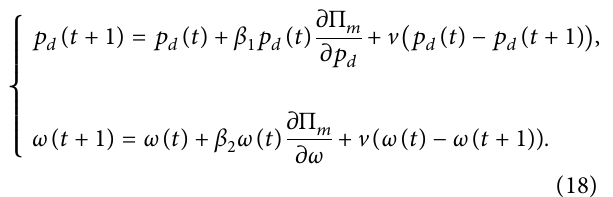
interval. v is the control parameter, indicating the degree of � 0 . 03 , β � 0 . 1 control over the difference. Then, we set β 1 2 and draw bifurcation diagram with increasing v as given in Figure 16. We show the control of the parameter to the system in Figure 16, where we can see that when v is small, the system is in chaos, and with the control parameter v increasing, the system goes into period doubling and becomes stable at the end. In conclusion, adjusting decision-making method to get over market delay is a good way of system control. Man- ufacturers can take this method in practice.